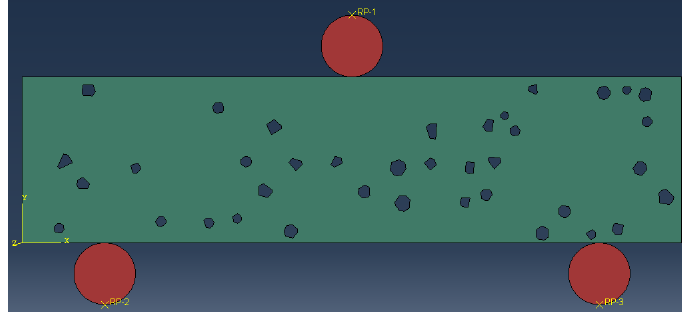
Figure 23. Rubber particles in a 2D CRM6 sample.